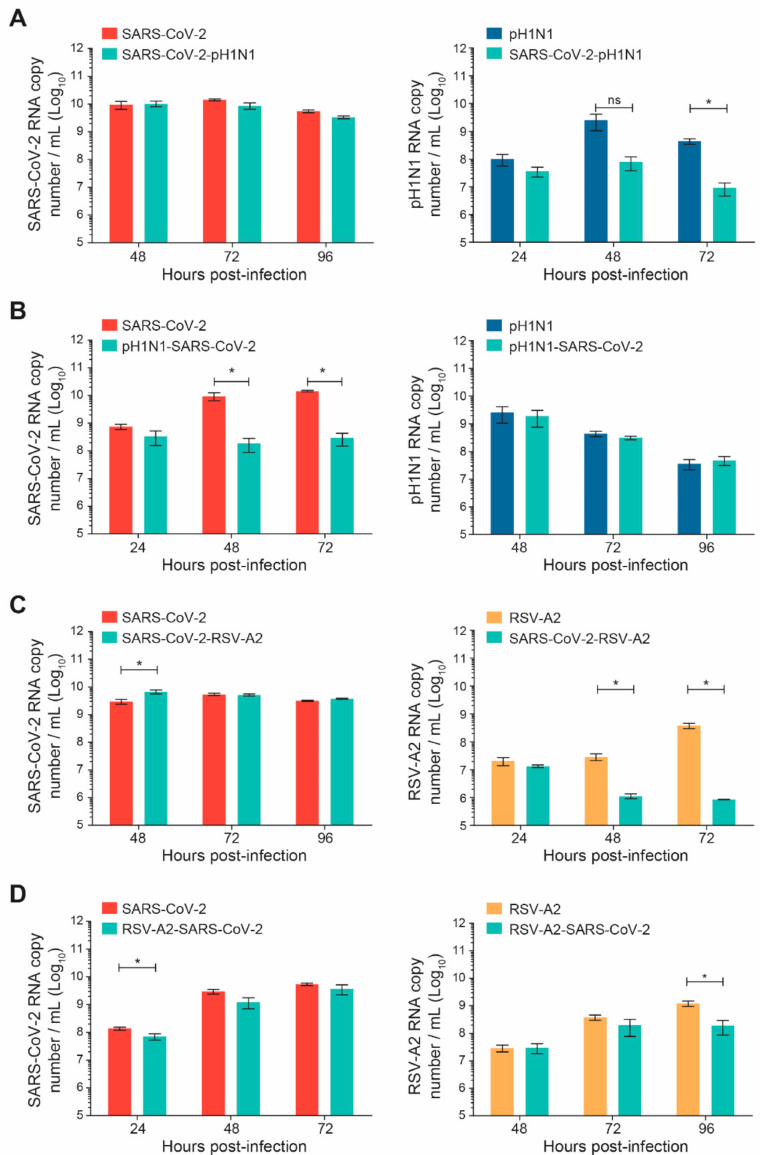
Figure 3. Replication kinetics of SARS-CoV-2 and influenza A(H1N1)pdm09 or RSV-A2 virus combi- nations on nasal human airway epithelium (HAE) during sequential infections compared to matched single-infection conditions. Nasal HAE was sequentially infected with SARS-CoV-2/influenza A(H1N1)pdm09 ( A , B ) or SARS-CoV-2/RSV-A2 ( C , D ) virus combinations 24 h apart at the apical pole. Single infections with each virus were performed in parallel. The MOIs were set at 0.015 (SARS-CoV-2/A(H1N1)pdm09 series) or 0.02 (SARS-CoV-2/RSV-A2 series) in single and dual in- fections. Viral loads of SARS-CoV-2, influenza A(H1N1)pdm09 and RSV-A2 were determined by RT-qPCR. Results represent the mean ± SEM of 2 independent experiments with duplicate HAE. ns, not significant; * p < 0.05 by the Mann–Whitney test. pH1N1, influenza A(H1N1)pdm09